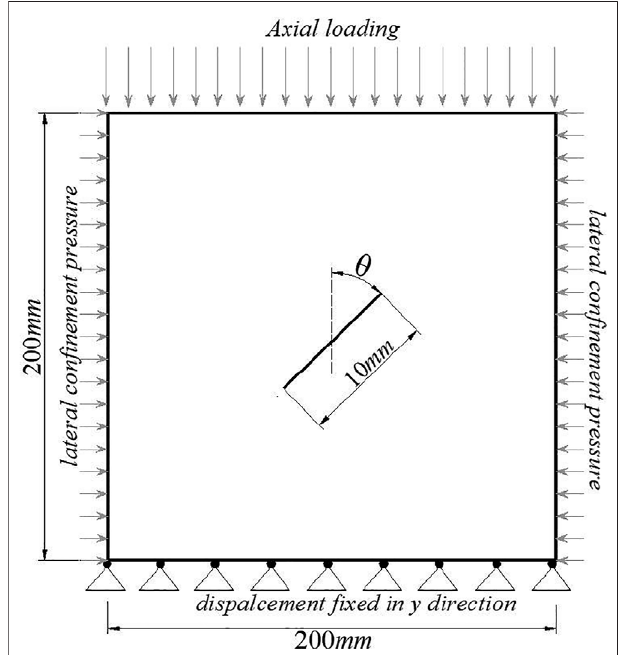
FIGURE 6 | XFEM model of an inclined crack in a rectangular plane.